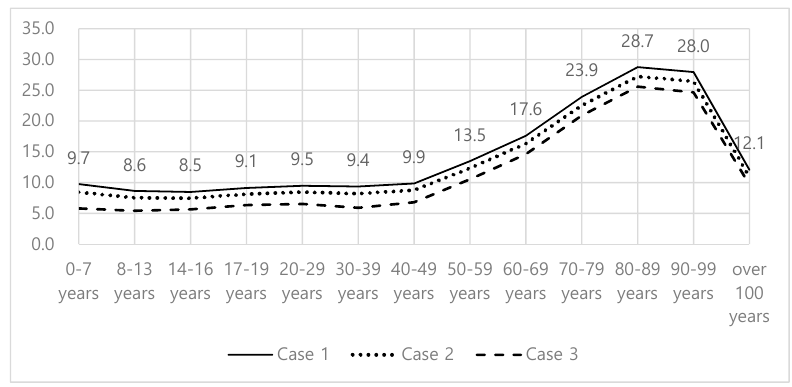
Figure 4. Proportion of the people with LFA by age group (unit: %).